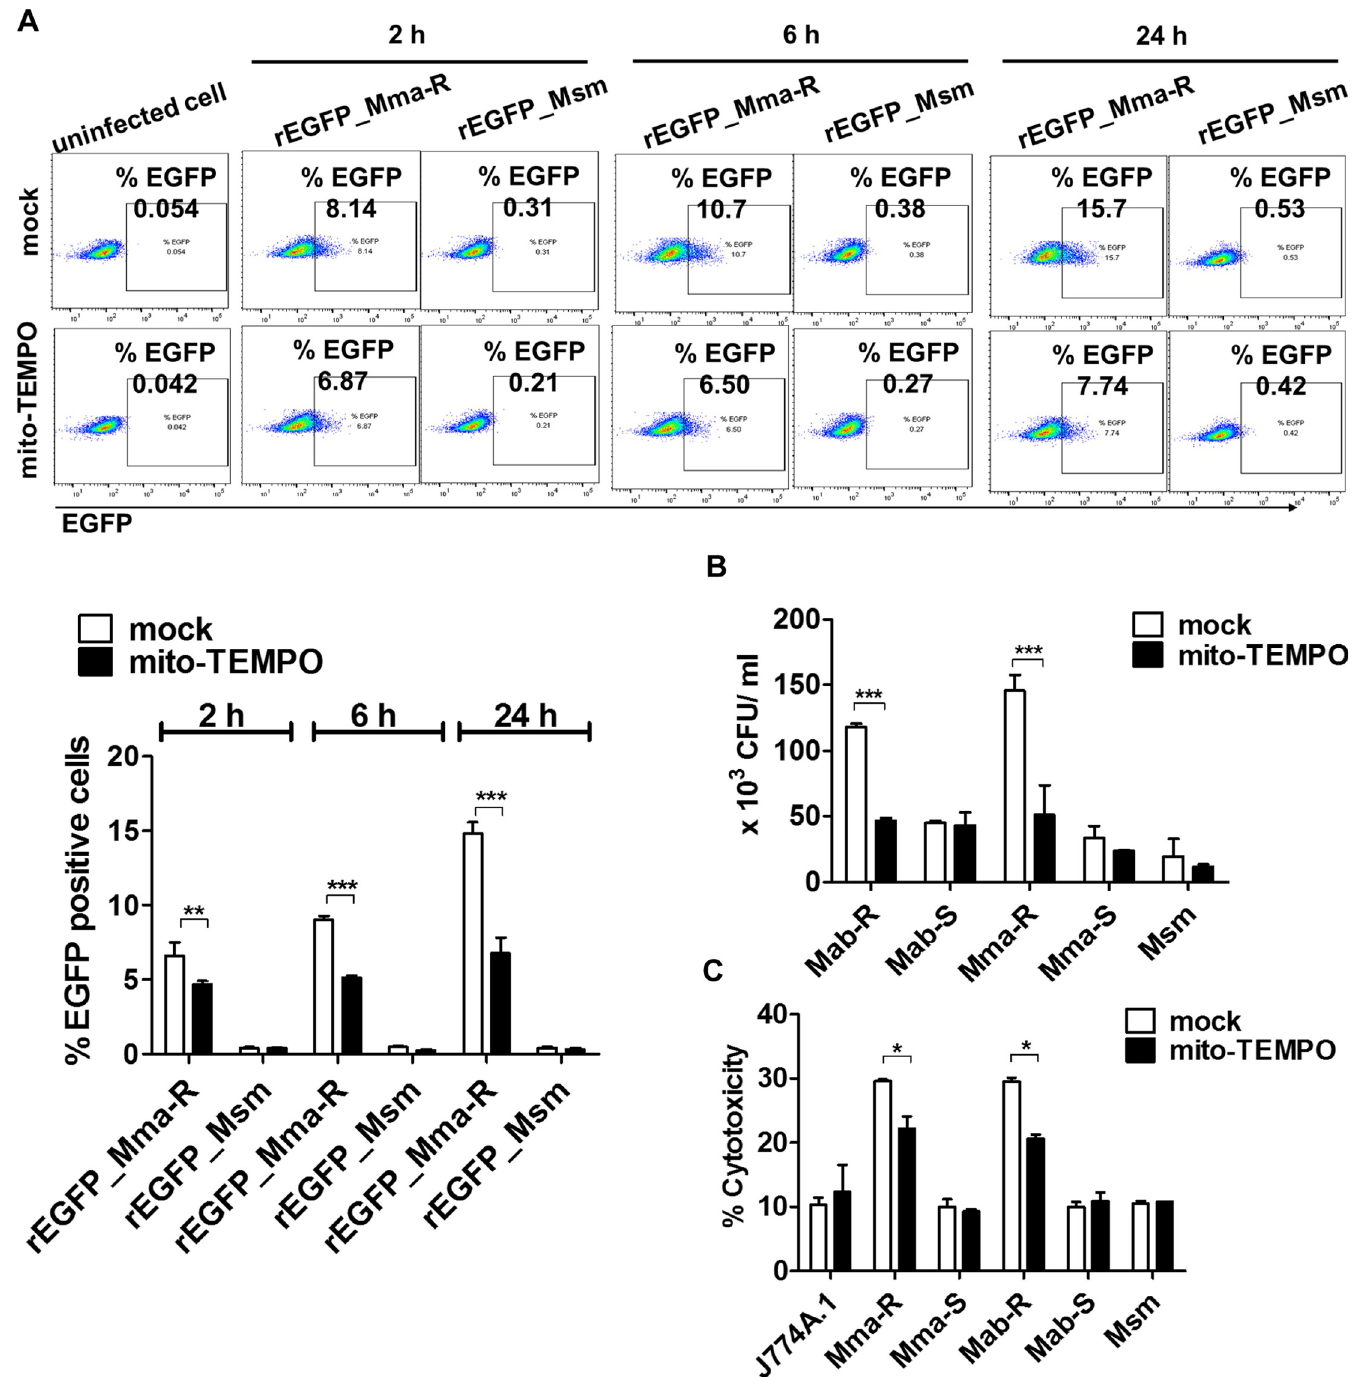
Fig 5. mtROS led to enhanced intracellular survival of MAB-R strains via IFN-I-dependent cell-to-cell spreading and enhanced cell cytotoxicity. (A) J774A.1 cells pre-treated with mito-TEMPO (100 μ M) and infected with rEGFP_Mma-R or rEGFP_Msm ( M . smegmatis ) at an M.O.I. of 10 for different times (2, 6 and 24 h). The percentage of EGFP-positive cells was measured by flow cytometry (FACSCalibur). (B) J774A.1 cells were pre-treated with mito-TEMPO and infected with strains of MAB-R, MAB-S or M . smegmatis (Msm) at an M.O.I. of 10 for 24 h. Infected cell lysates were serially diluted and plated onto 7H10 agar plates for CFU assays. (C) Cytotoxicity was quantitated by measuring lactate dehydrogenase (LDH) in the infected cell supernatants. Error bars represent the SD. Statistical significance was determined by two-tailed Student’s t -test (A-C).